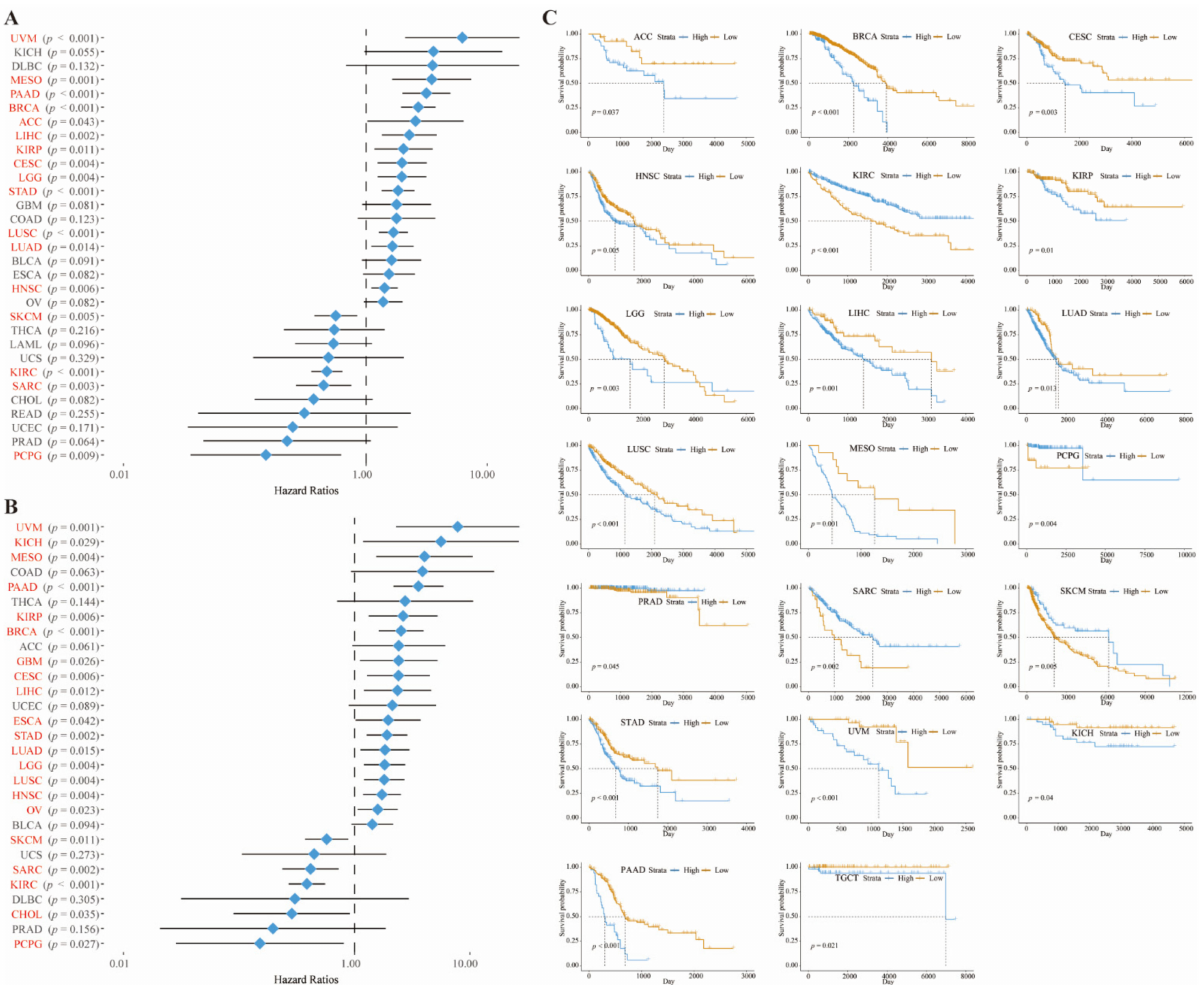
Figure 2. CD73 exhibits significant prognostic value in a variety of cancers. Forest plot showed the prognostic role of CD73 in OS ( A ) and DSS ( B ) analysis. KM method showed the prognostic role of CD73 in OS analysis ( C